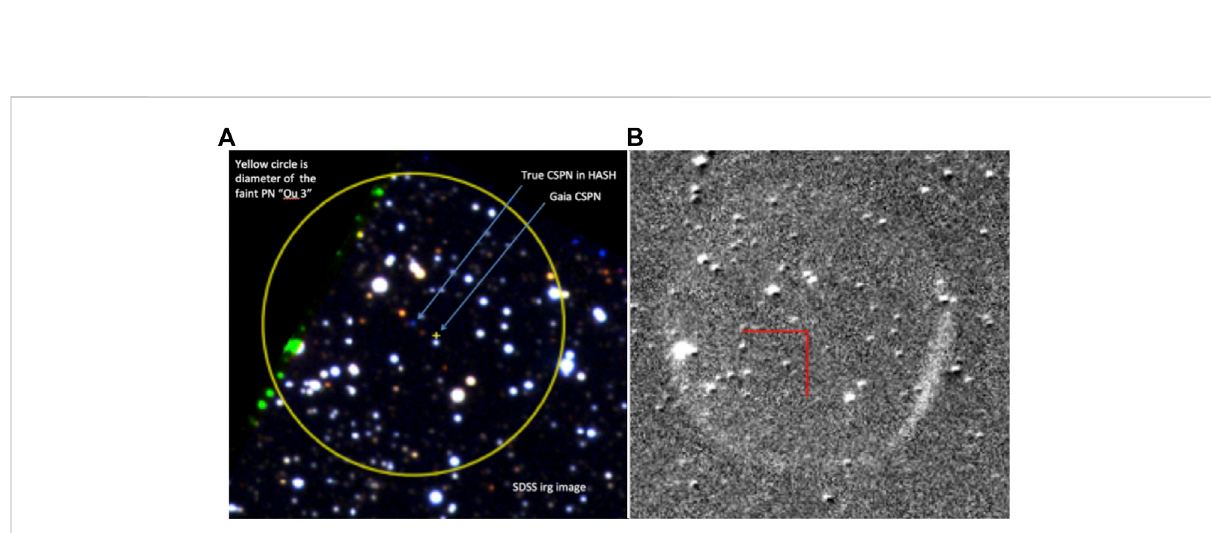
FIGURE 6 (A) : Annotated SDSS i,r and g band 2 × 2 arcminute RGB image of PN Ou 3 (PN G059.2 + 01.0) with North-East to top left. The incorrect CSPN identi fi ed by Gaia and the actual, faint, blue CSPN identi fi ed in HASH are arrowed. (B) : IPHAS H α /R band quotient image of Ou three that shows the round 90arcseconds diameter PN and thetrue CSPNlocation shown. This example shows thebene fi tsofthewide variety ofdeep imagery available within HASH and the problems of correct CSPN identi fi cation, even with Gaia. A version of the same image has appeared in Parker et al.